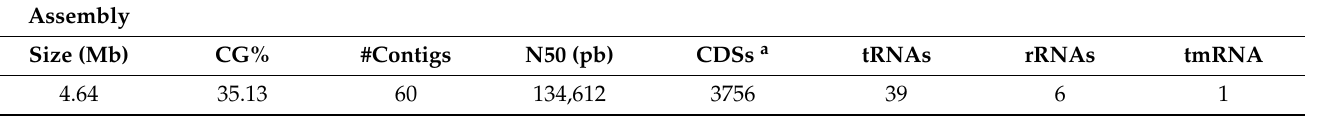
Table 1. Overview of the genome characteristics for the final assembly of the L. interrogans strain NEG7 genome.